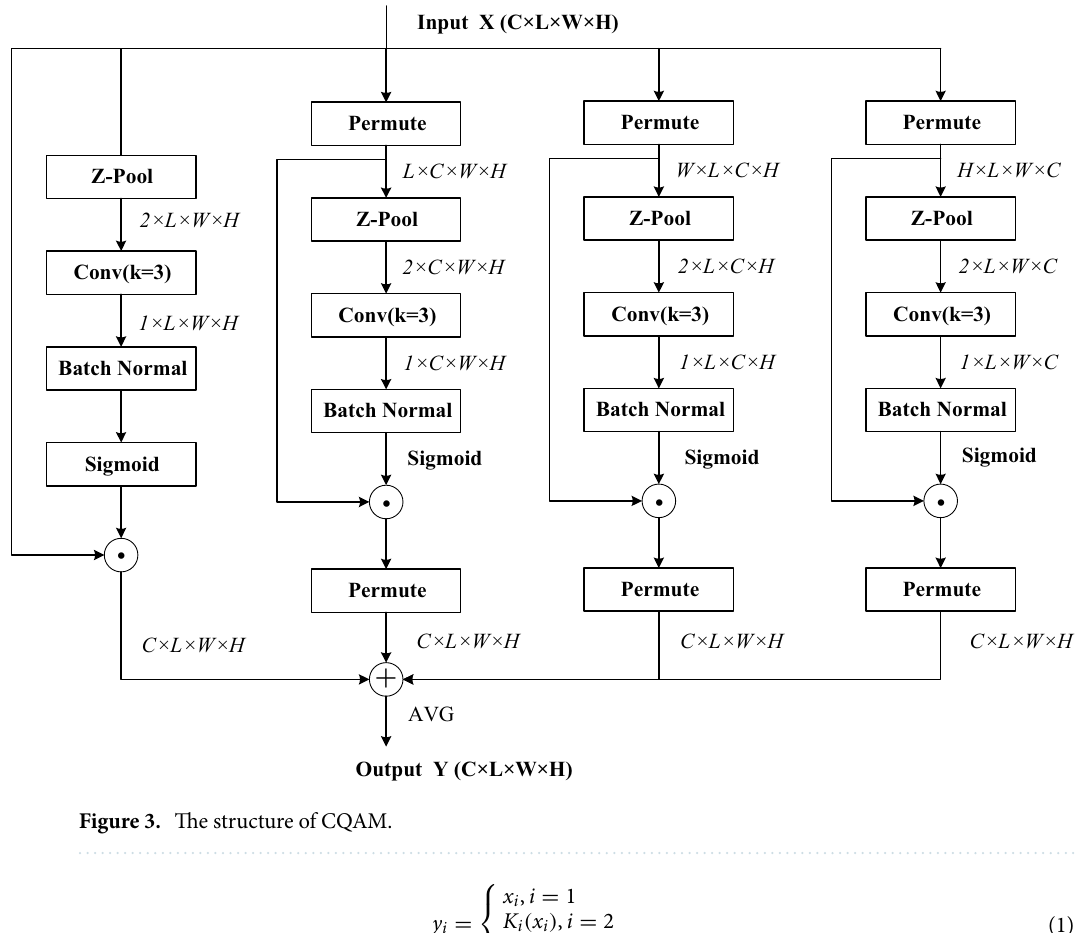
Figure 3. The structure of